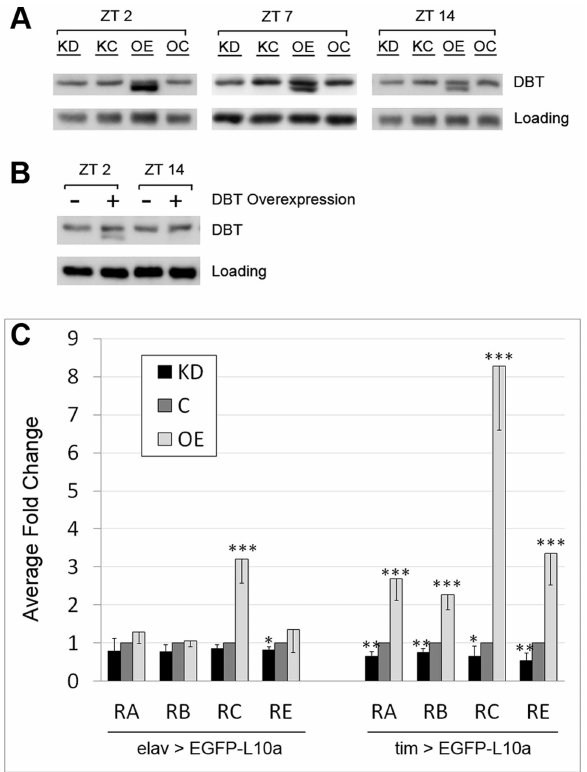
Figure 2. LARK regulates the translation of DBT transcripts. A, Western Blot showing the effect of pan-neuronal LARK knock-down (KD) and overexpression (OE) on DBT abundance assayed at three different zeitgeber times (ZTs). B, Overexpression of DBT alone renders detection of the shorter isoform at ZT2 but not ZT14. A non-specific band was used as loading control in A and B. C, Analyses of dbt mRNA translation using the TRAP method. All samples were collected at ZT2. Left, effect of altered LARK expression in all neurons. Right, effect of altered LARK expression in clock cells. Note that values for KD and OE are respectively normalized to KC and OC; thus the values of both controls were designated as ‘‘1’’ and plotted as one control denoted ‘‘C’’. Fold changes were calculated from Ct values obtained from Q-RT- PCR that had been normalized to an internal Rp49 control. Average fold change from at least 6 Q-RT-PCR experiments are shown. Error bar represents SEM. *** p , 0.001, ** p , 0.01, * P , 0.05 based on Student’s t test comparing the Rp49-normalized Ct values of KD versus KC and OE versus OC.